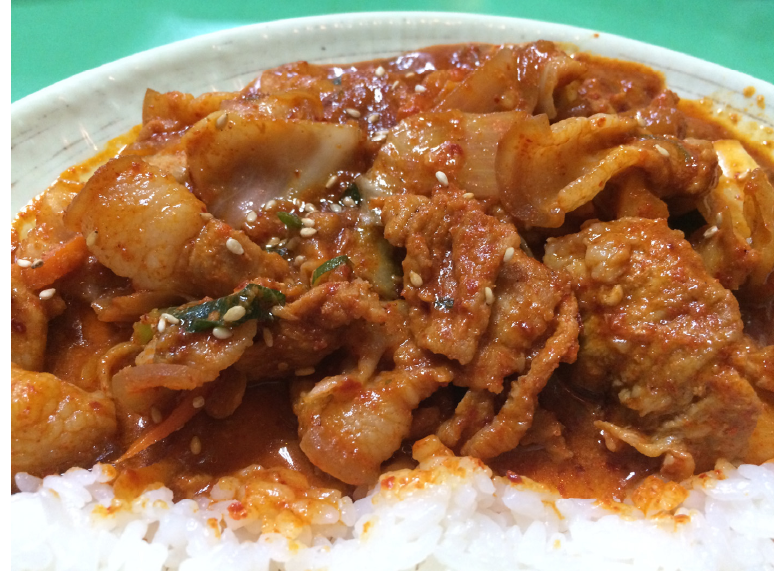
Figure A5. Ingredients: pork, cabbage, onion, chili, spring onion, carrot, and condiments (red chili paste, red chili powder, mirin, soy sauce, sugar, garlic, ginger juice, pepper, sesame oil); see recipe at: http://www.maangchi.com/recipe/dwaejigogibokkeum.